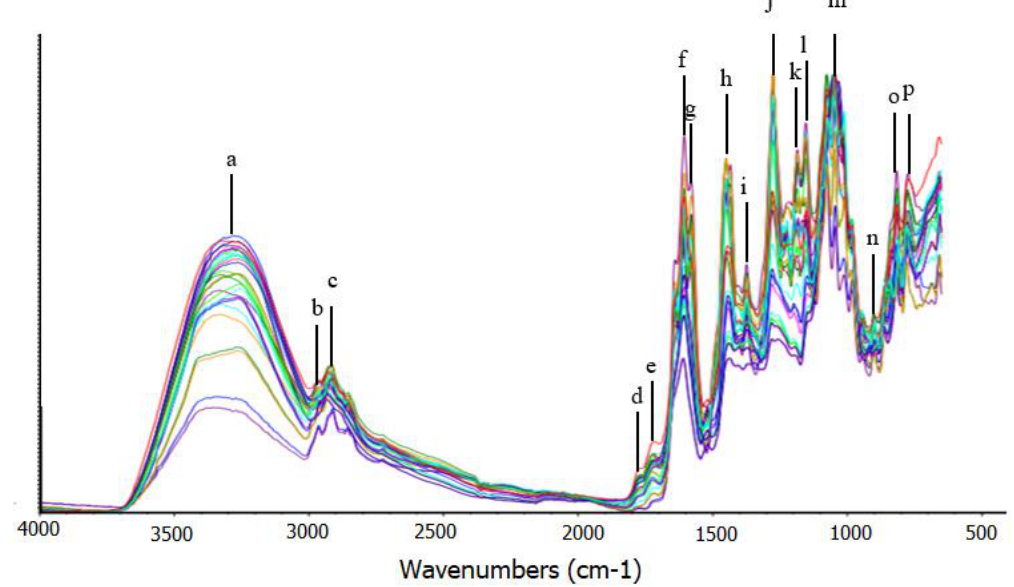
Figure 3. FTIR spectra of ethanolic extract of mangosteen pericarp, scanned at mid infrared region 4000–650 cm − 1 , using attenuated total reflectance.